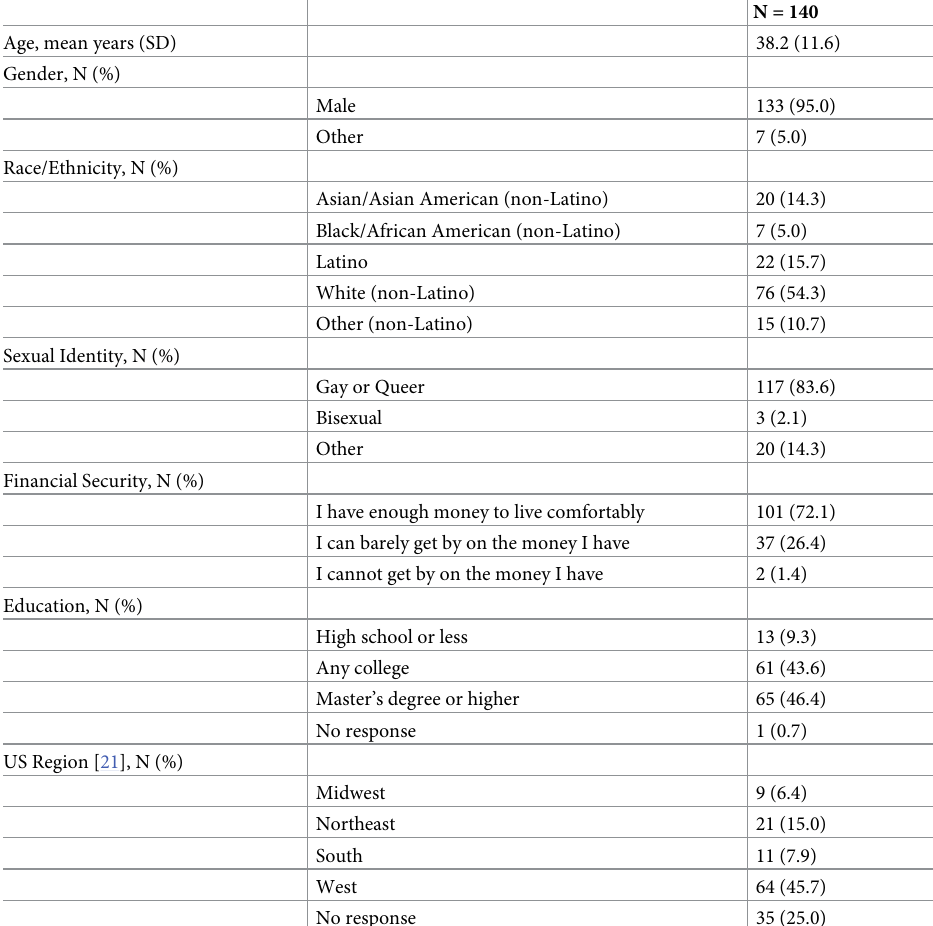
Table 1. Summary of participant